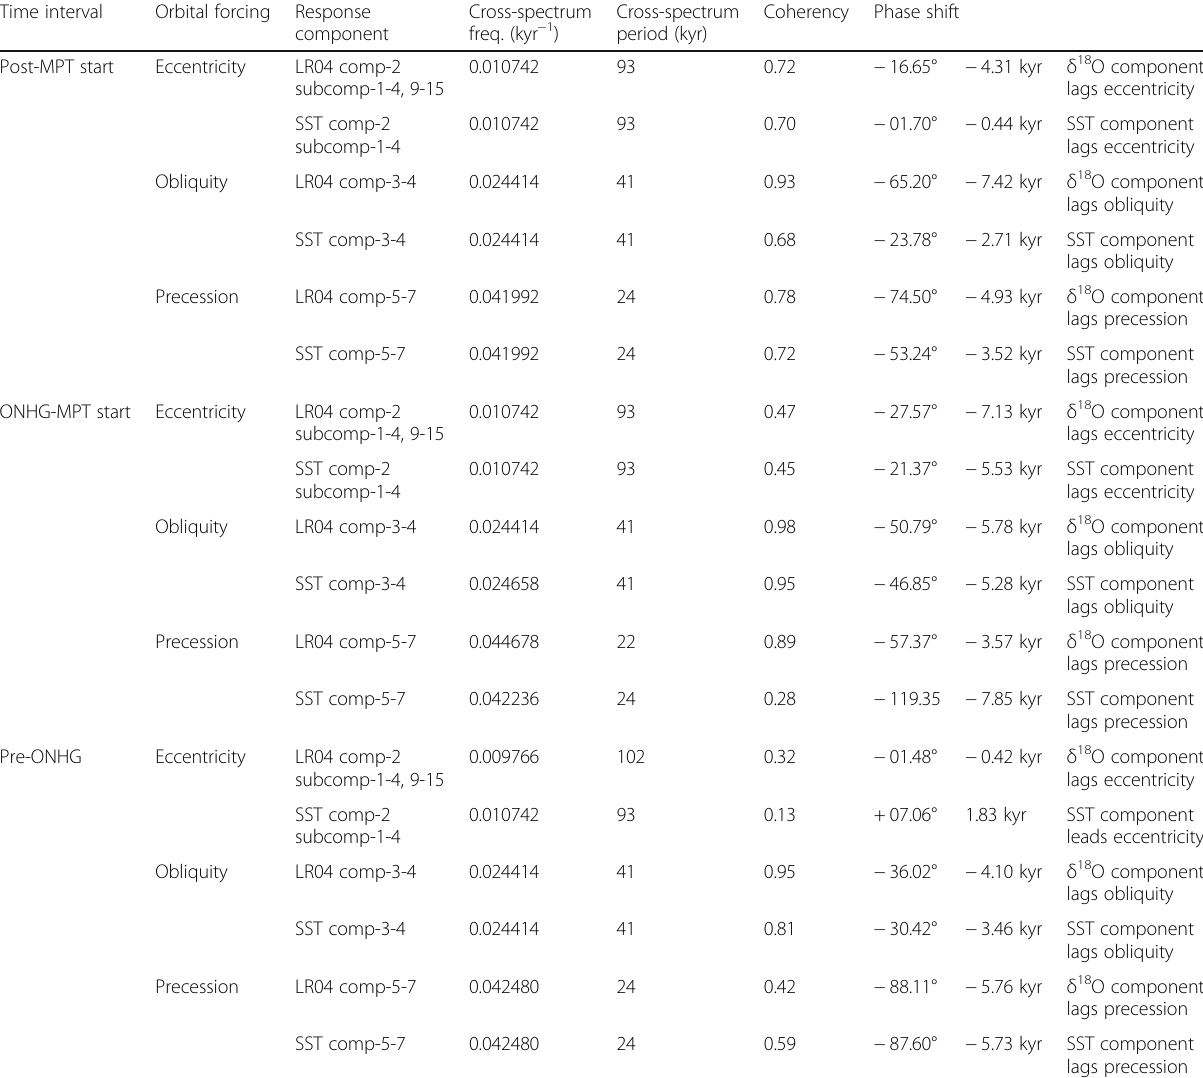
Table 8 Cross-spectral analysis results among the orbital forcings (Laskar et al. 1993) and the orbitally driven δ 18 O and SST components for three time intervals. Data standardized (mean = 0, standard deviation = 1) and, where necessary, inverted to have the same paleoclimatic polarity (positive values for positive forcing and